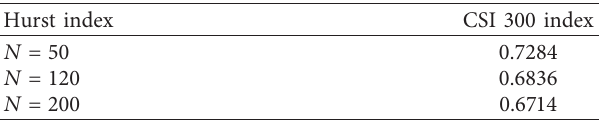
Table 2: The Hurst exponent results of the CSI 300 index.